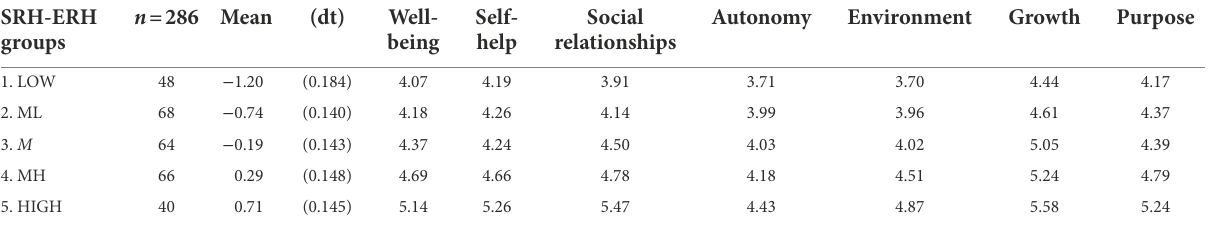
TABLE 19 Descriptive statistics for the groups formed ( n = 286). SRH-ERH groups